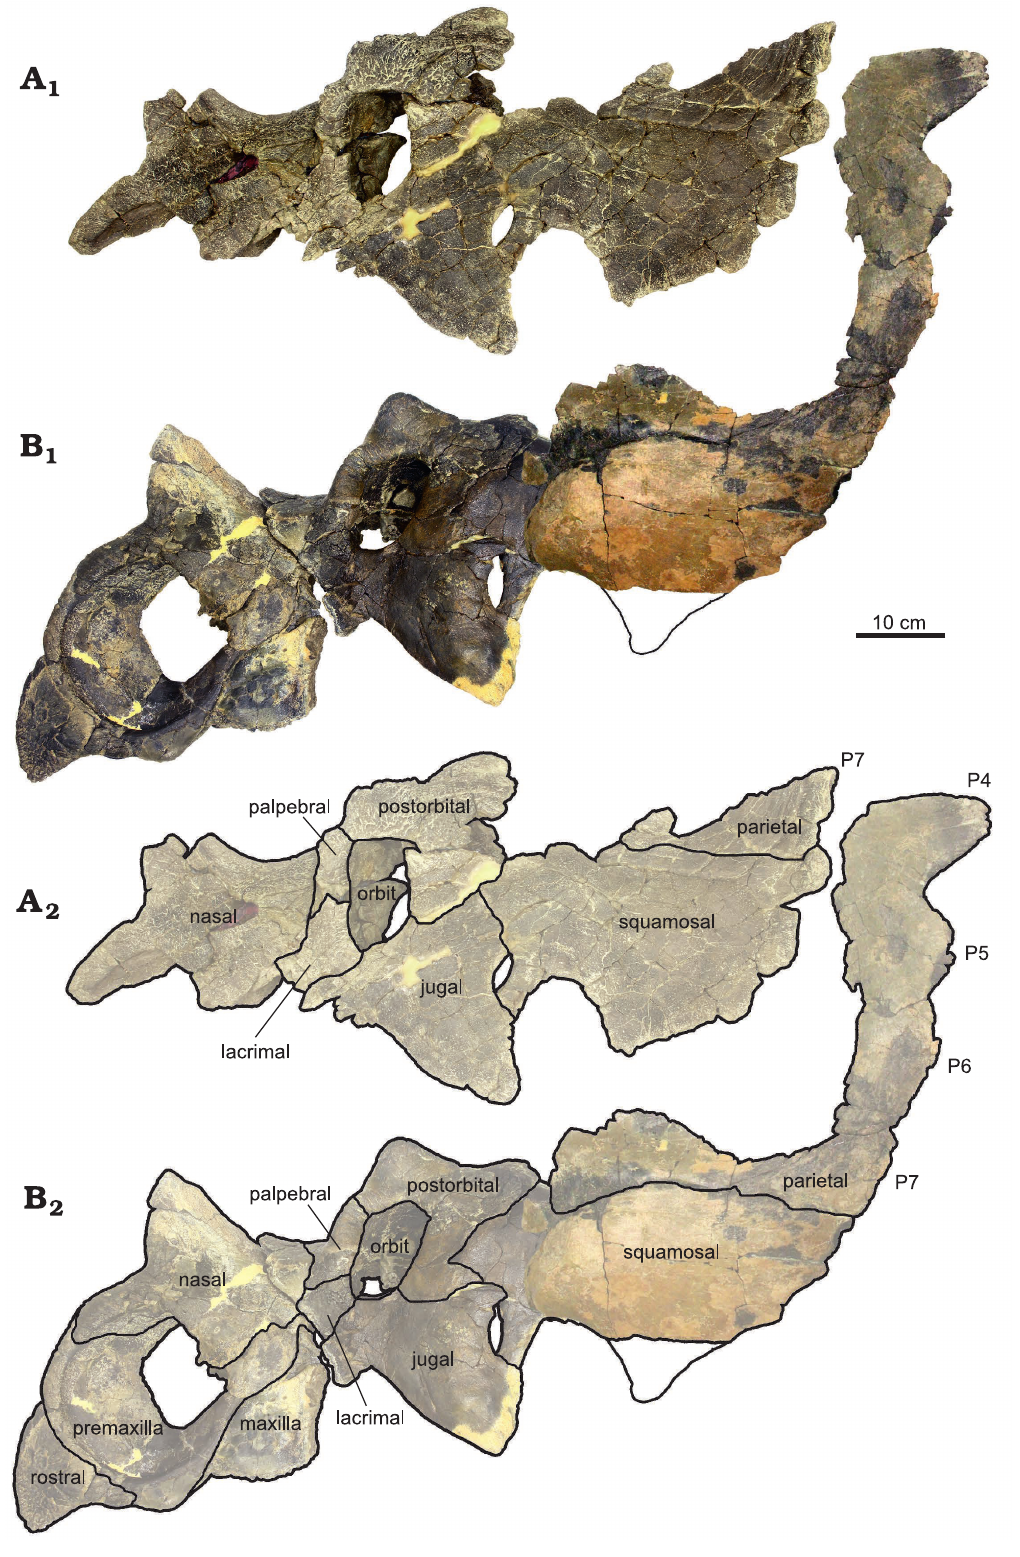
Fig. 1. Lateral views of articulated crania of subadult eucentrosaurans from the Campanian Two Medicine Formation, Montana, USA. A . Einiosaurus procurvicornis Sampson, 1995, MOR 456 8-8-87-1. B . Eucentrosauran ( Einiosaurus procurvicornis or Achelousaurus horneri Sampson, 1995), MOR 591. Photographs (A 1 and B 1 ), osteological line drawings (A 2 , B 2 ). Face of MOR 591 mirrored, with parietosquamosal frill superimposed. The contact outlines between the postorbital, jugal, and squamosal in A 2 are estimated due to lack of externally visible sutures and may appear different from MOR 591 due to some breaks and gaps. P4–P7, parietal